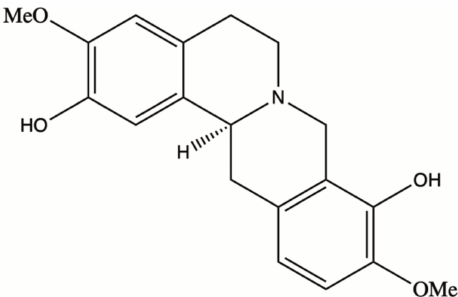
Figure 1. Scoulerine